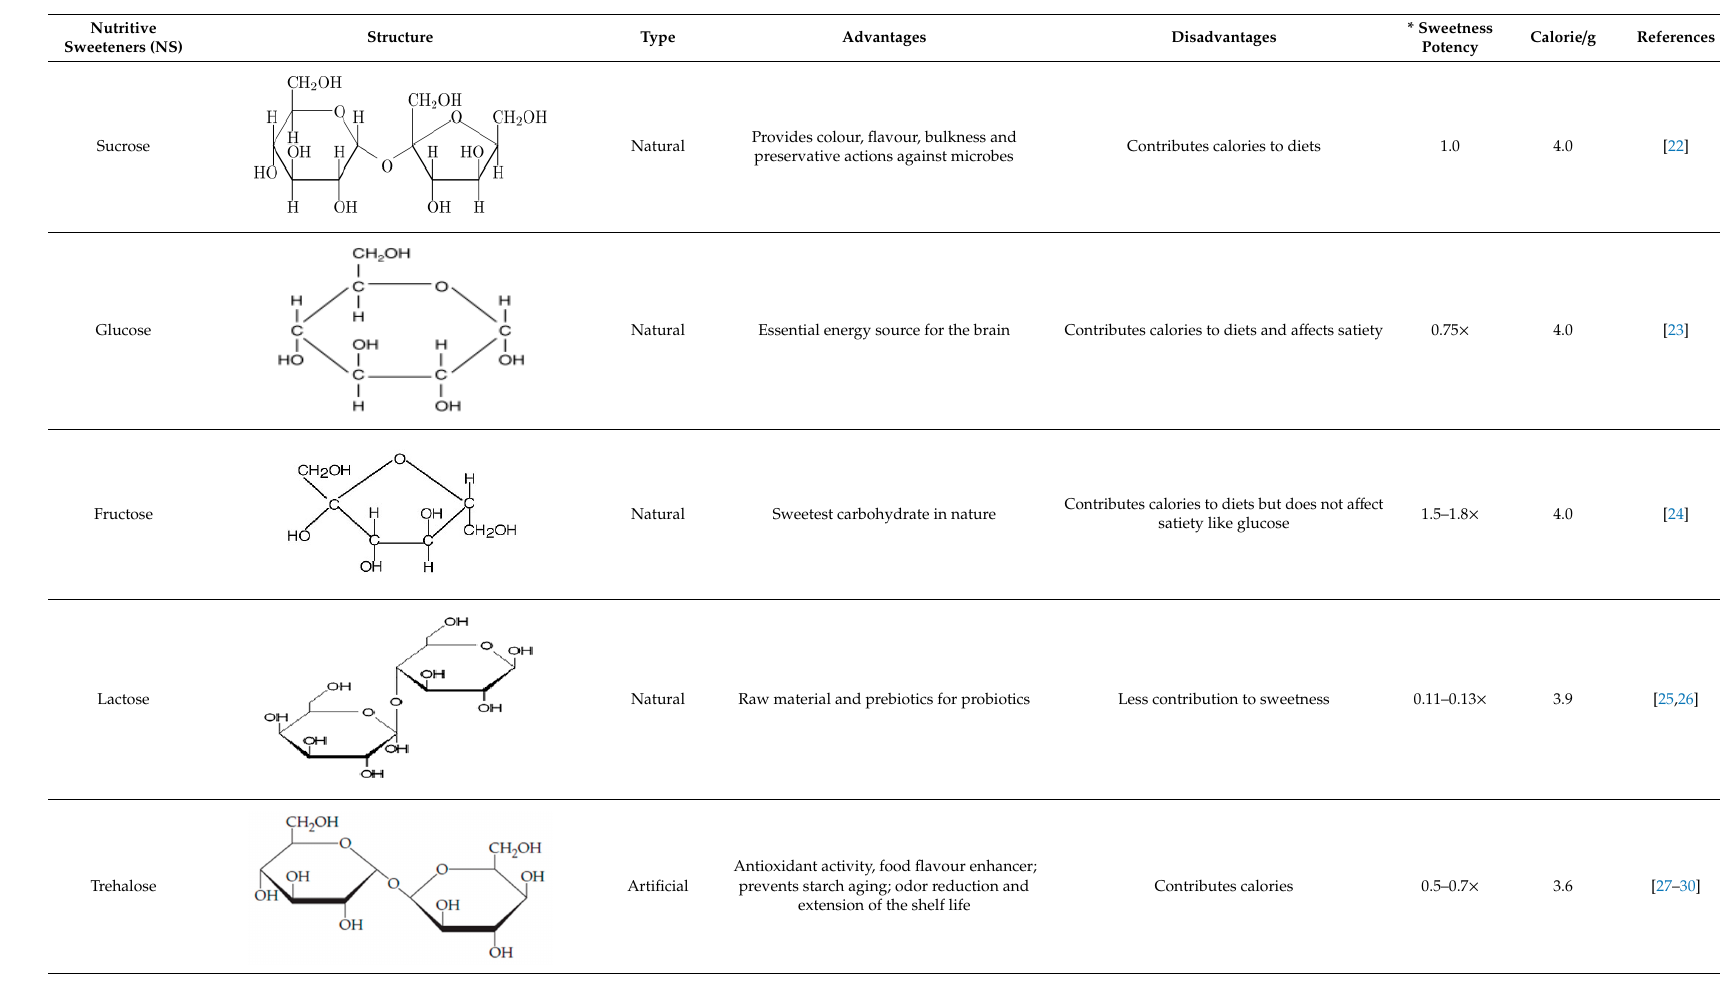
Table 1. Natural and artificial nutritive sweeteners (NSs), their advantages, disadvantages, sweetness potency, and calorie contribution. Nutritive Sweeteners (NS)